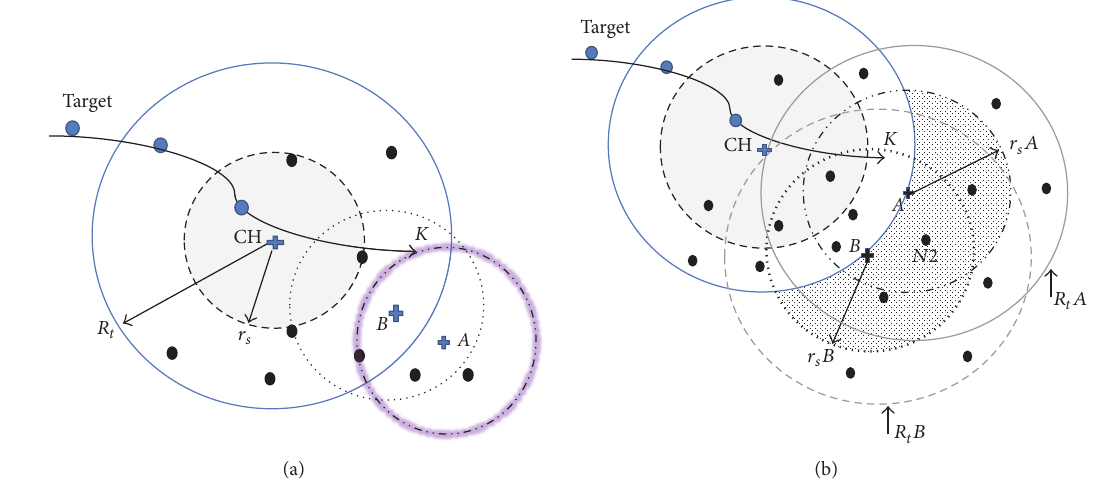
Figure 3: Overlap problem between clusters.